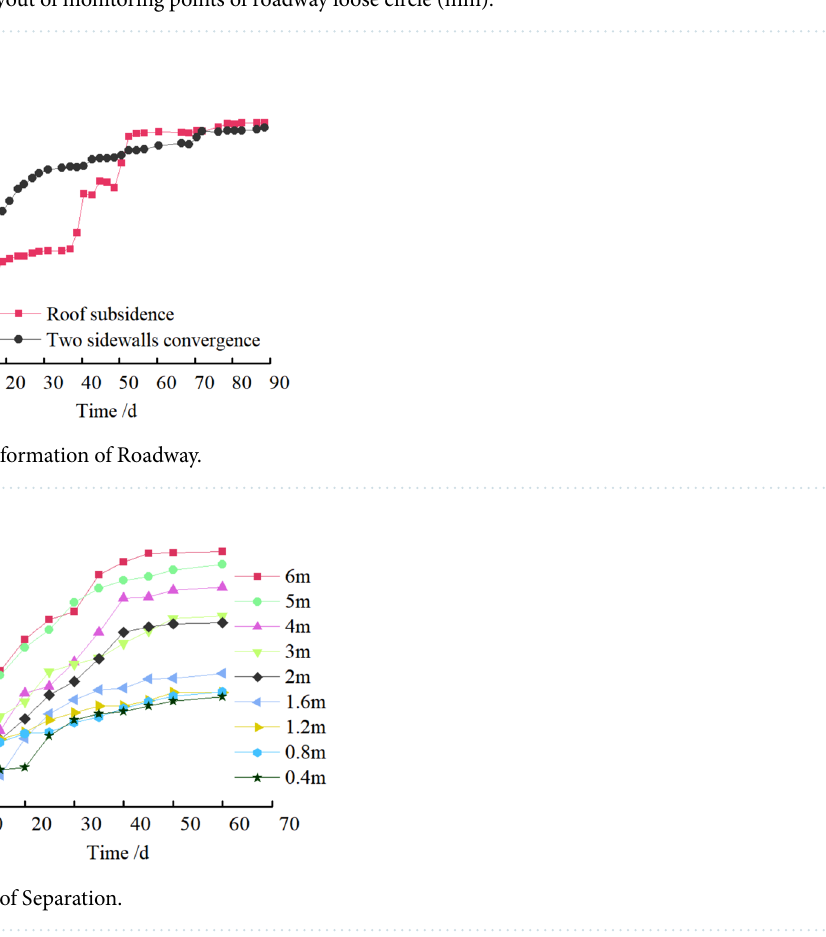
Figure 31. Layout of monitoring points of roadway loose circle (mm).